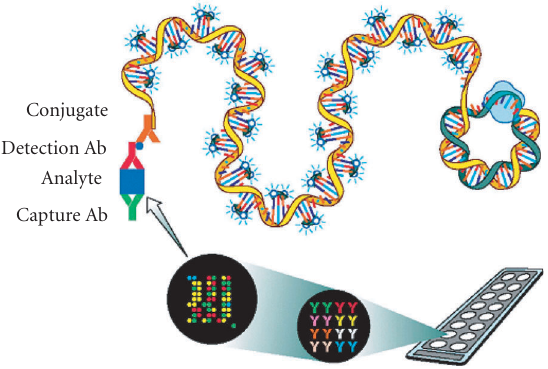
Figure 1. Schematic representation of microarray immunoas- say with RCA signal amplification. It consists of (a) analyte capture by antibody immobilized on microarray, (b) detection by biotinylated secondary antibody, (c) binding of antibiotin antibody-oligonucleotide conjugate pre-annealed with circle 1, and (d) rolling-circle replication to generate long single-strand DNA which is hybridized with oligonucleotide decorator.